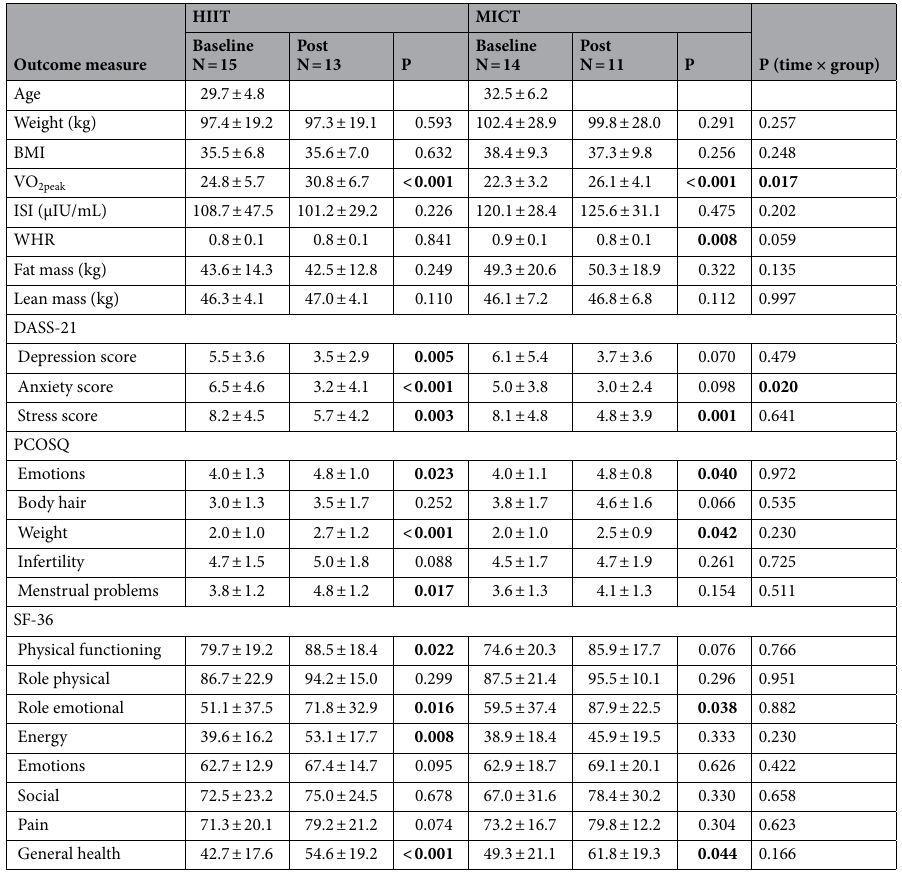
Table 1. Mental health and health-related quality of life outcomes at baseline and post-intervention. Significant values are in bold. Data are mean ± SD. BMI body mass index, DASS-21 depression, anxiety and stress scale—21 items, HIIT high-intensity interval training, ISI insulin sensitivity index, MICT moderate- intensity continuous training, PCOSQ polycystic ovary syndrome questionnaire, SF-36 short-form survey—36 items, VO 2peak peak oxygen consumption, WHR waist to hip ratio.